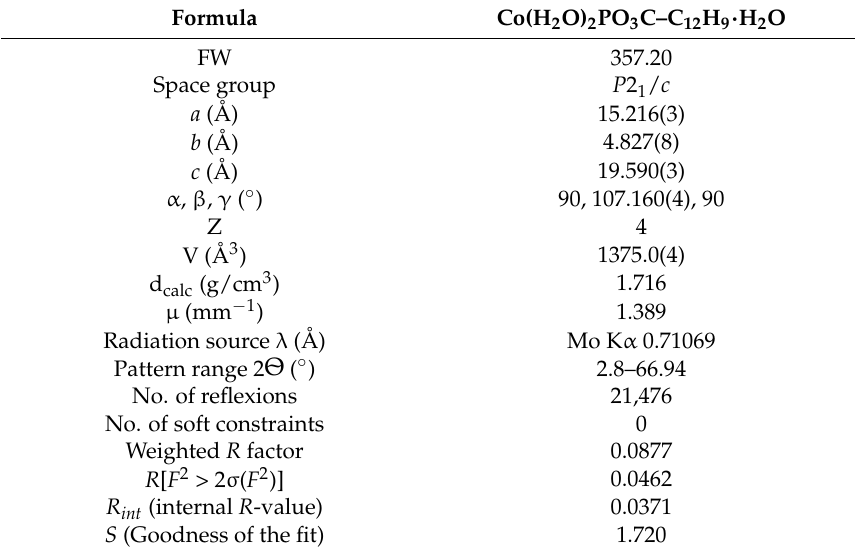
Table 1. Crystallographic data of Co(H 2 O) 2 PO 3 C–C 12 H 9 · H 2 O.